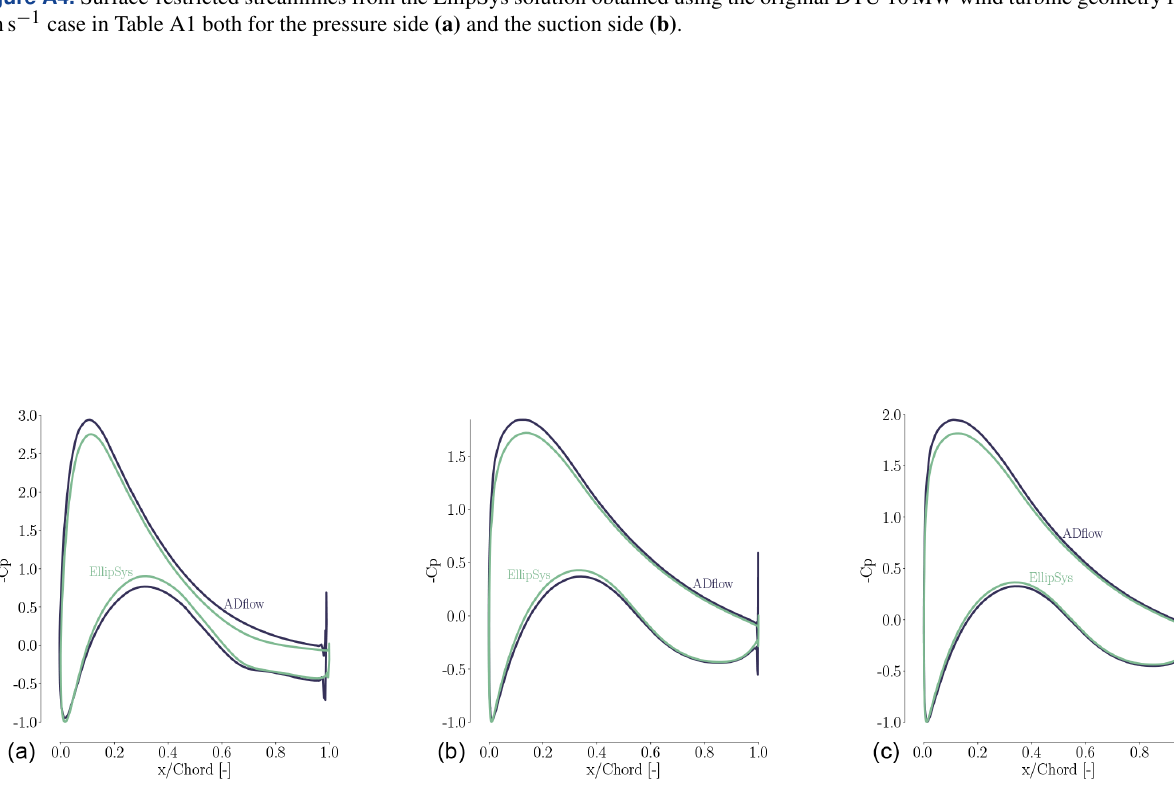
Figure A4. Surface-restricted streamlines from the EllipSys solution obtained using the original DTU 10MW wind turbine geometry for the